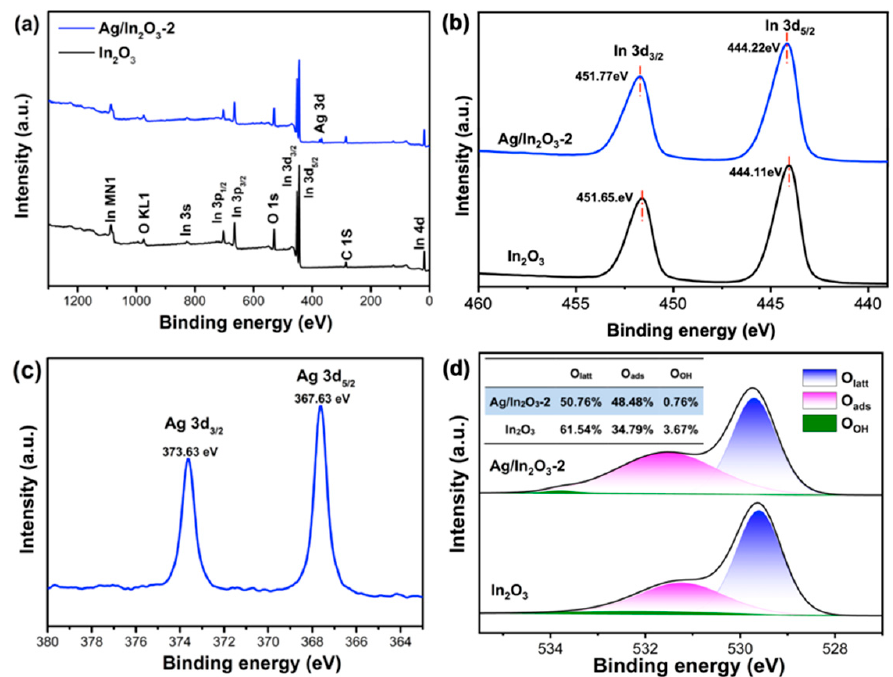
Figure 3. XPS spectra of the In 2 O 3 and Ag/In 2 O 3 -2: ( a ) full survey spectra, ( b ) high-resolution In 3d spectra, ( c ) high-resolution Ag 3d spectrum of Ag/In 2 O 3 -2, and ( d ) high-resolution O 1s spectra. The specific surface area and porosity of In 2 O 3 and Ag/In 2 O 3 -2 were investigated by N 2 adsorption and desorption method, as shown in Figure 4. Both samples show clear hysteresis loops at P/P 0 = 0.6–1 and their isotherms increase rapidly at the position near P/P 0 = 0, revealing the co-existence of micro- and mesoporous structures in In 2 O 3 and Ag/In 2 O 3 -2. From their pore diameter distribution plots (insets of Figure 4a,b), the dominant diameters of micropore and mesopore are 1.88 and 29.24 nm for bare In 2 O 3 and 1.17 and 14.63 nm for Ag/In 2 O 3 -2, respectively. Based on the BET method, the calculated specific surface areas of In 2 O 3 and Ag/In 2 O 3 -2 are 13.20 and 16.39 m 2 g − 1 , respectively.